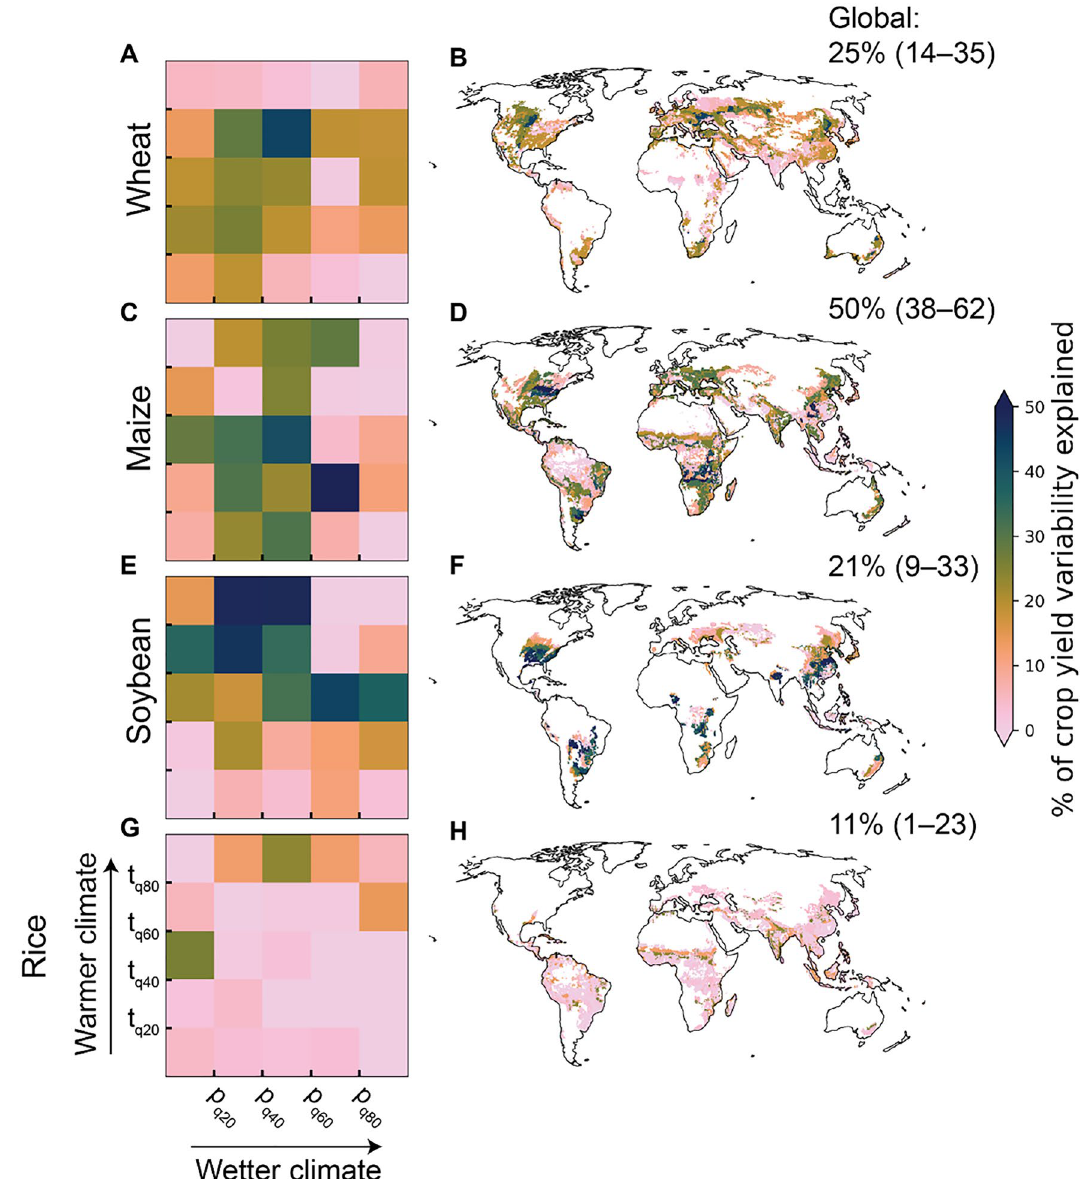
Figure 1. Explanatory power of the XGBoost regression model in estimating crop yield anomalies with growing season weather data at global and climate bin level. Results are shown for studied crops: wheat ( A , B ), maize ( C , D ), soybean ( E , F ), and rice ( G , H ). See map and division of the climate bins, defined based on quintiles of climatological temperature (t) and precipitation (p), for each crop in Fig. S2. The XGBoost model was trained globally as well as for each climate bin separately (see “Methods”). The results presented in the climate bin matrices and maps show the amount of crop yield variability explained with the models trained for each climate bin separately, whereas the global results are presented in the upper right corner of each map. The crop yield anomalies were estimated for each grid cell separately and always for years, which were not used in training the model (i.e. the estimates are out-of-sample predictions). Uncertainty in the global results was evaluated by training the model 100 times, while randomly sampling the years in each training and validation set. The proportion of crop yield variation explained by the models was calculated as the squared Pearson’s correlation coefficient (sign preserved) between reported and estimated crop yield anomalies aggregated (with a harvested area-weighted average) to global and climate bin level. For the global results, the values in the brackets indicate 95% confidence interval of the proportion of crop yield anomaly variability explained by the models. The maps presented in the figure were created with Matplotlib and Cartopy Python modules 38–40